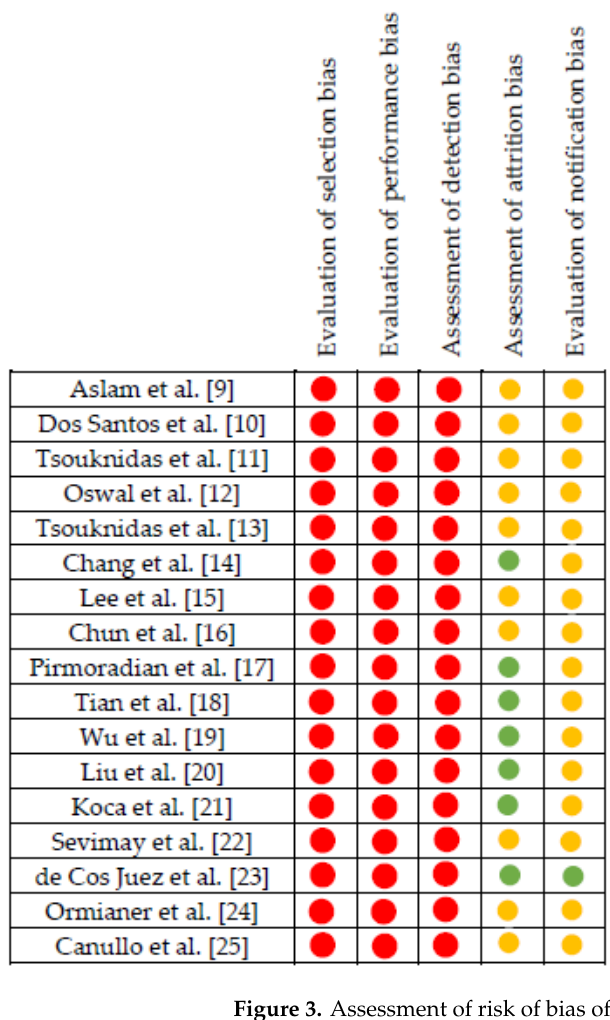
Figure 3. Assessment of risk of bias of included studies.